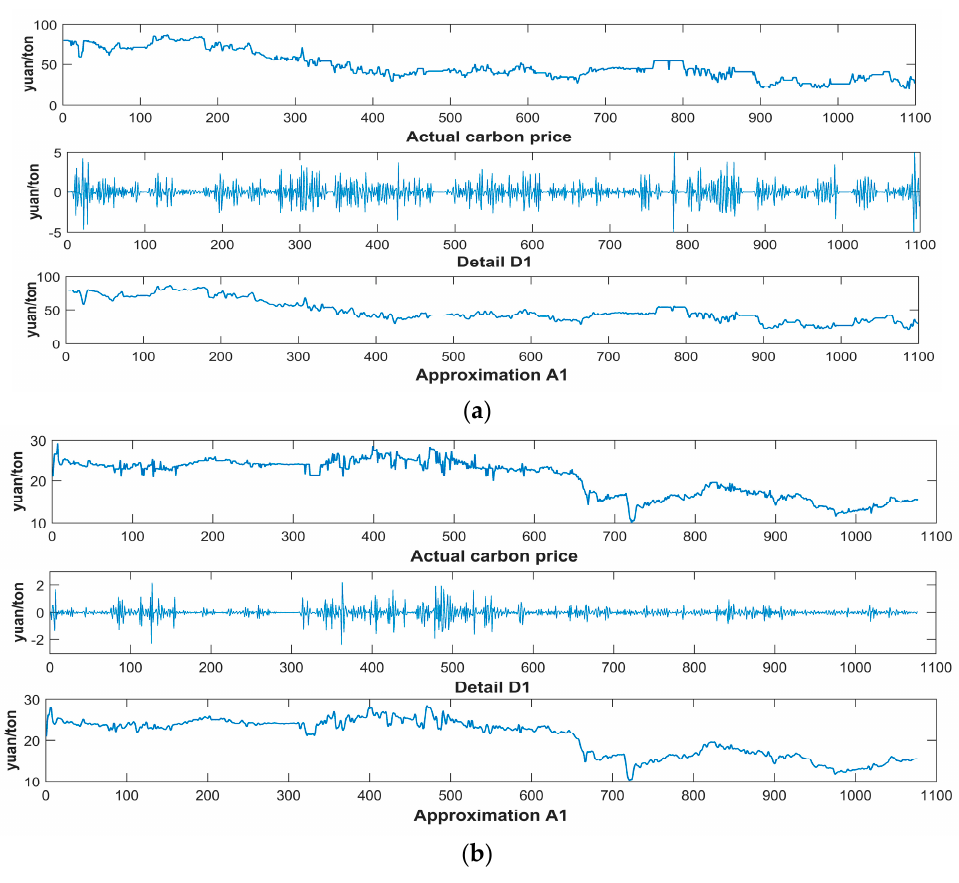
Figure A2. ( a ) The Shenzhen carbon price after WT decomposition; ( b ) The Hubei carbon price after WT decomposition. Table A3. The new subsequences after being processed by FEEMD and EMD for the prediction of the Shenzhen carbon price.